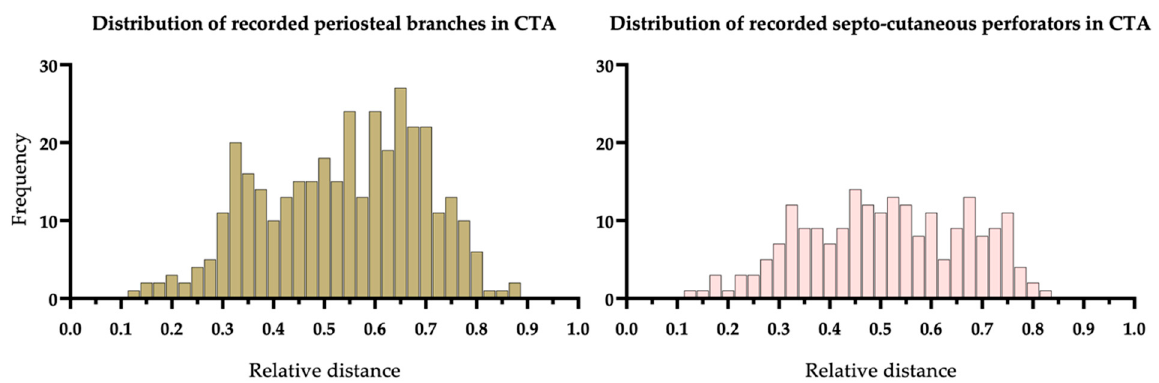
Figure 4. ( Left ) Distribution of periosteal branches ( n = 361) and ( Right ) septo-cutaneous perforators ( n = 213) of the FA demonstrated by the CTA. The origin of the vessels is scaled concerning the total length of the fibula and given as relative distance.